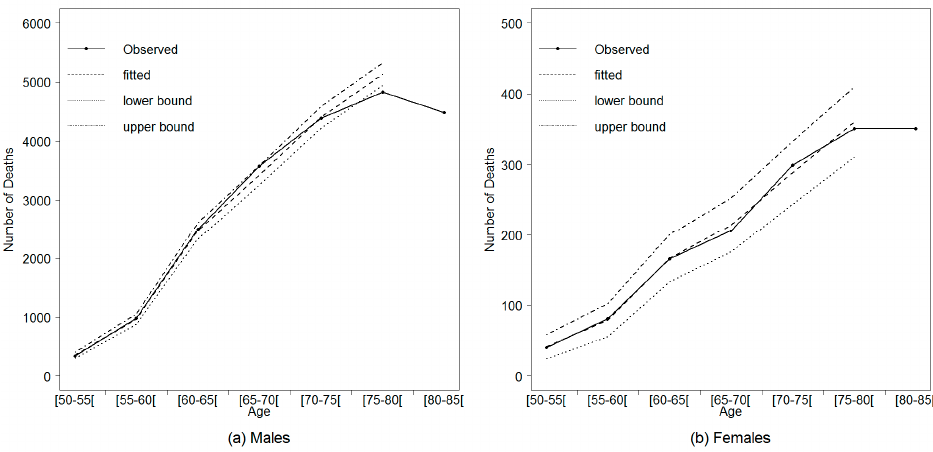
Figure 12. Confidence bounds of the numbers of deaths predicted by the linear regression model, for males and females.